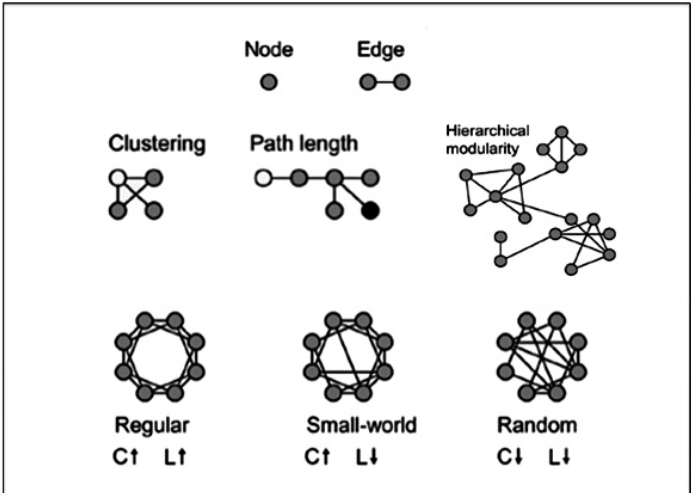
Figure 2. Core measures of graph theory: nodes and edges, clustering coefficient, characteristic path length, Small World index, modularity.